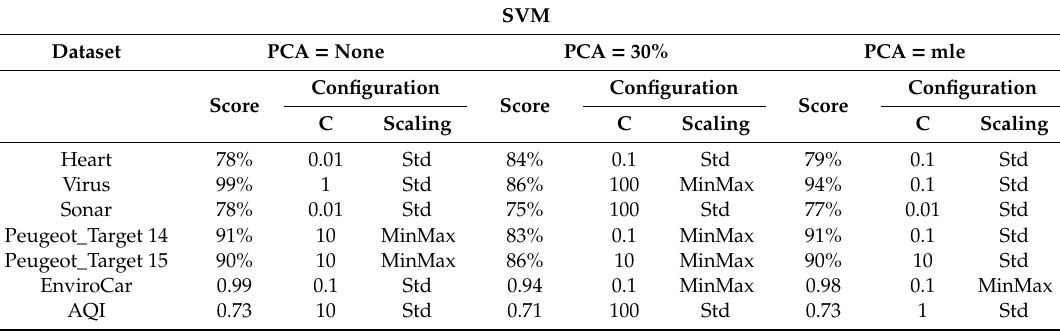
Table 19. SVM performance and configuration for various PCA